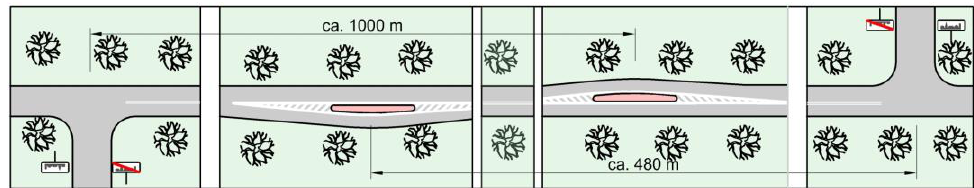
Figure 5. A non-typical transition zone with two staggered chicanes deflecting the traffic lanes in the opposite directions. Source: own work of the authors.